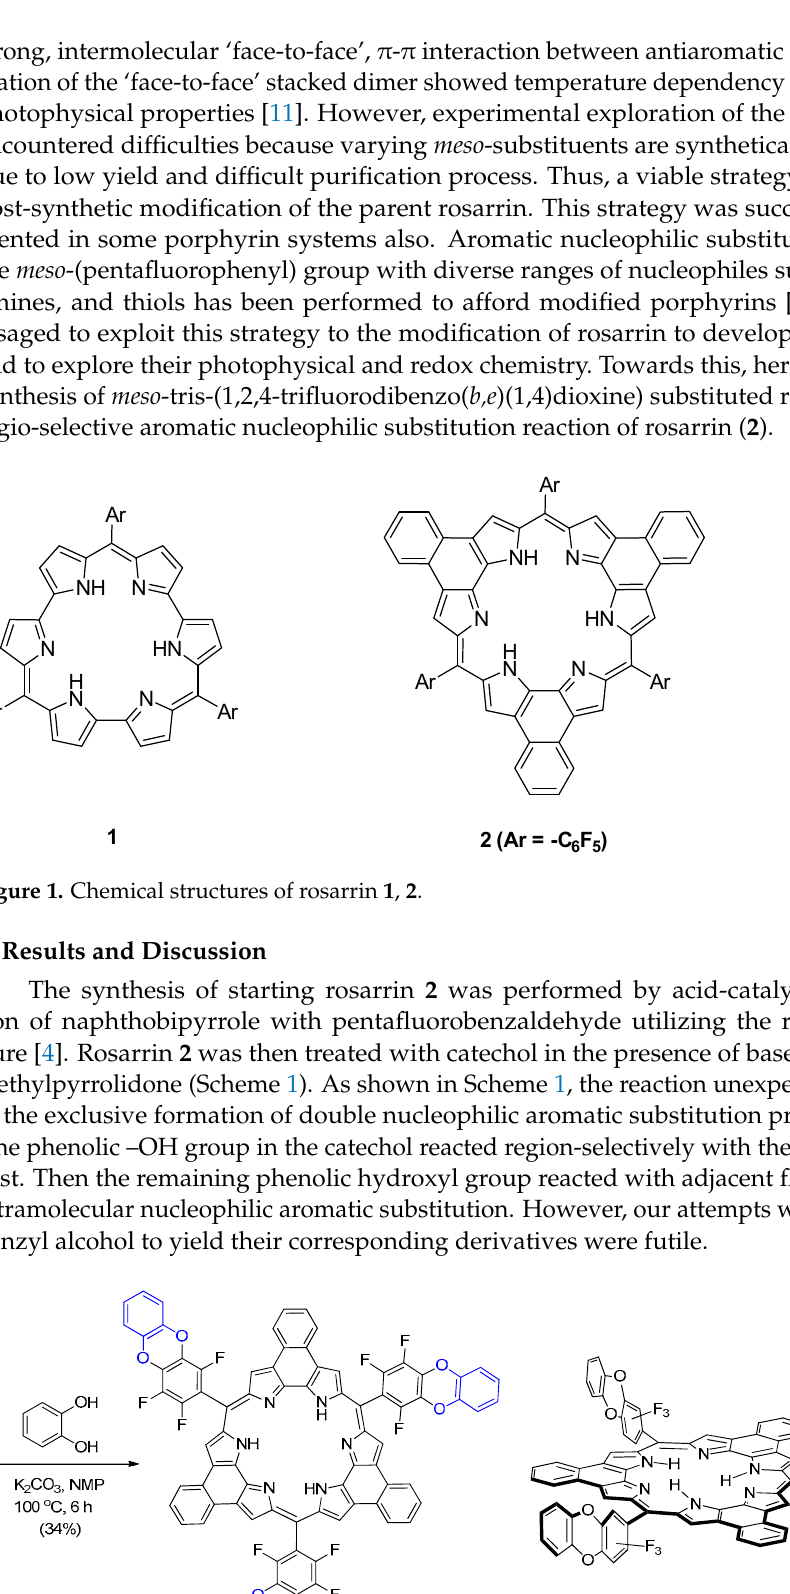
Figure 1. Chemical structures of rosarrin 1 , 2